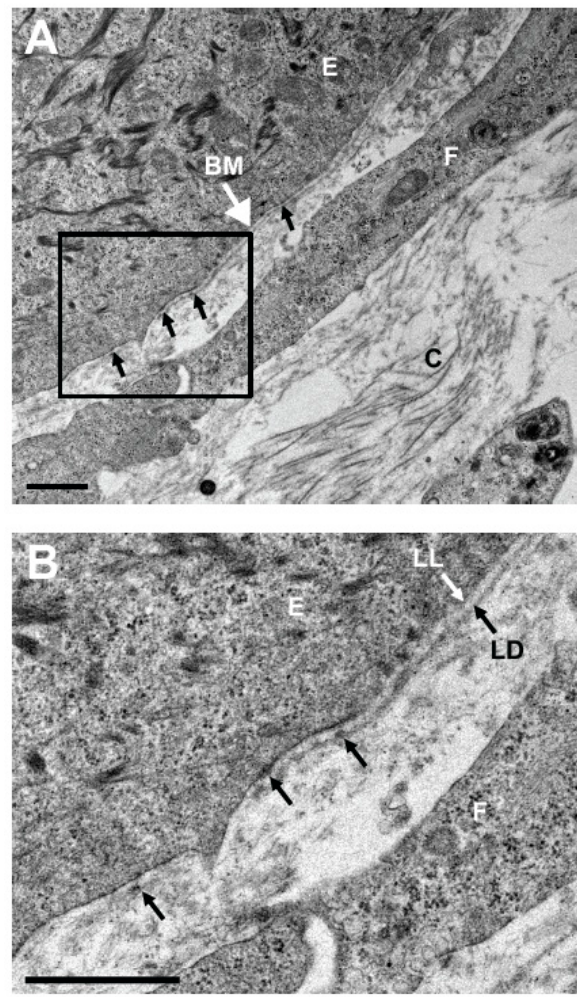
Figure 4. Transmission electron microscopic analysis of the hTEC. ( A ) Electron microscopic examination of the hTEC revealed the presence of an organized basement membrane (BM) with many hemidesmosomes (arrows) that attach basal corneal epithelial cells (E) to the underlying fibroblast sheet (F). A basement membrane is present at the junction between the epithelium and the stroma. Note the presence of the collagen fibers (C) surrounding the fibroblasts in the sheet. ( B ) Higher magnification that shows both the lamina lucida (LL) and lamina densa (LD), as well as the hemidesmosomes (arrows) are present in the BM. Scale bars: 1 µm.